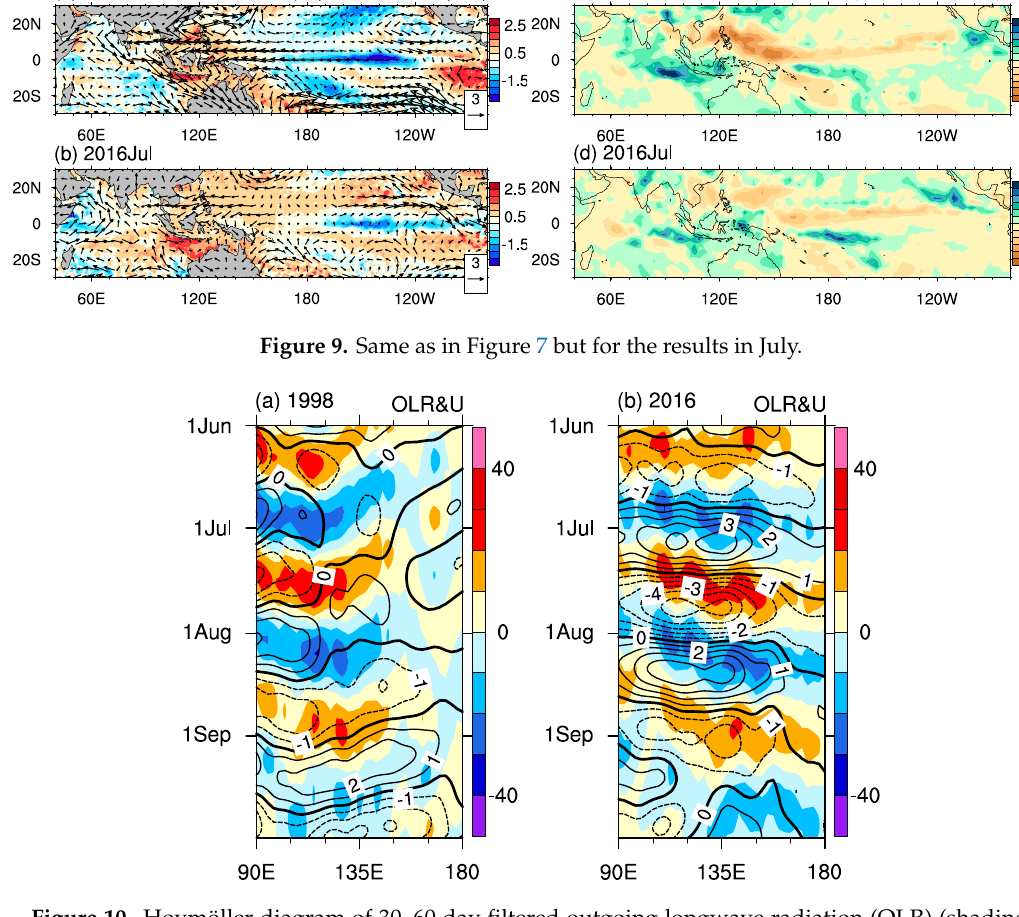
Figure 10. Hovmöller diagram of 30–60 day filtered outgoing longwave radiation (OLR) (shading, units: W/m 2 ) and 850 hPa zonal wind (contour, units: m/s) averaged from 5 °N to 15 °N in ( a ) 1998 and ( b ) 2016.